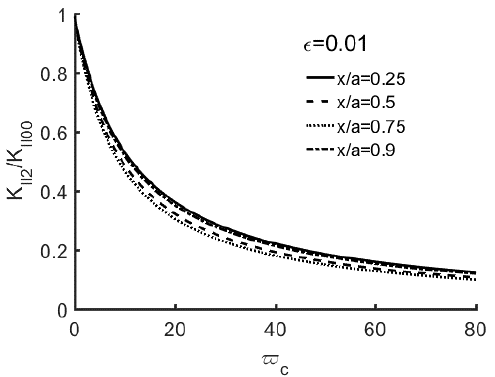
Figure 4. 𝐾 𝐼𝐼2 /𝐾 𝐼𝐼20 versus 𝜛 𝑐 with 𝜀 = 0.01 and 𝑥/𝑎 = 0.25, 0.5, 0.75, 0.9. Figure 4. K II 2 / K II 20 versus (cid:118) c with ε = 0.01 and x / a = 0.25, 0.5, 0.75,